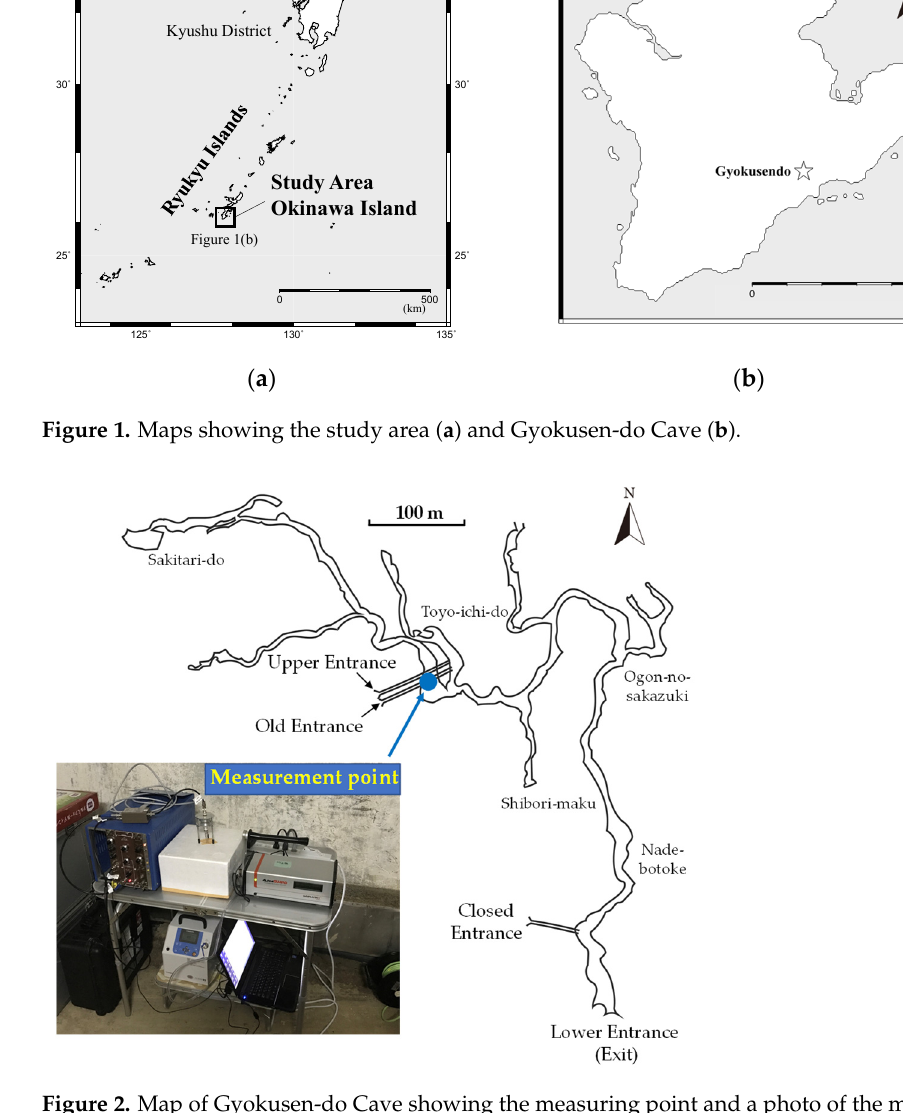
Figure 1. Maps showing the study area ( a ) and Gyokusen-do Cave ( b ).